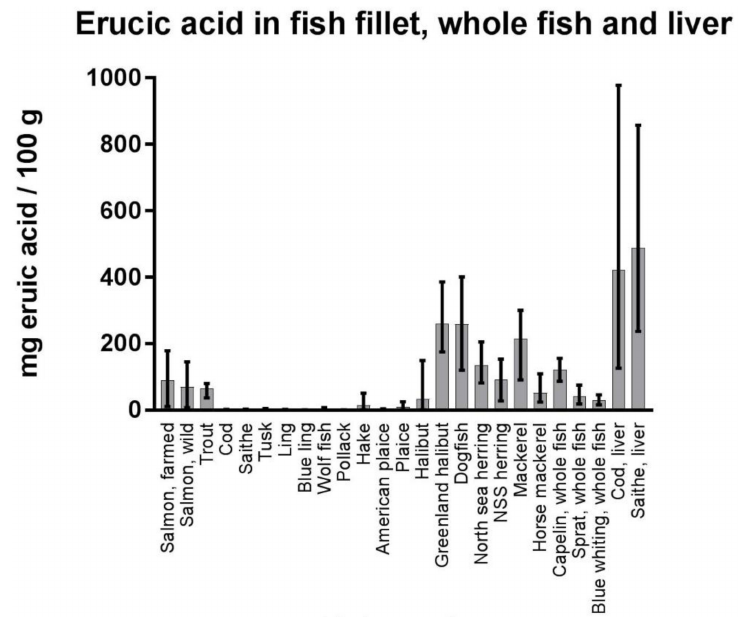
Figure 5. Content of erucic acid (22:1n-9), given as mg fatty acid/100 g sample in fish (in fillets if not otherwise specified, as well as some data for whole fish and fish livers towards the right of the figure). The bars show the mean values of erucic acid, as well as the minimum and maximum values. The number of samples analyzed for each category (N) are as follows; salmon, farmed n = 590, salmon, wild n = 99, trout n = 16, cod n = 60, saithe n = 40, tusk n = 63, ling n = 70, blue ling n = 10, wold fish n = 3, pollack n = 50, hake n = 46, American plaice n = 5, plaice n = 20, halibut n = 68, Greenland halibut n = 18, dogfish n = 15, North sea herring n = 19, NSS herring n = 30, mackerel n = 20, horse mackerel n = 21, capelin (whole fish) n = 10, sprat (whole fish) n = 8, blue whiting (whole fish) n = 10, cod liver n = 51, saithe liver n = 30. Many of the values were below the level of quantification (LOQ) for the analytical method, which is 1mg/100g. When some values were below the LOQ, 0 was used in calculation of the mean (lowerbound LOQ). Source of data: from the Institute of Marine Research’ seafood database